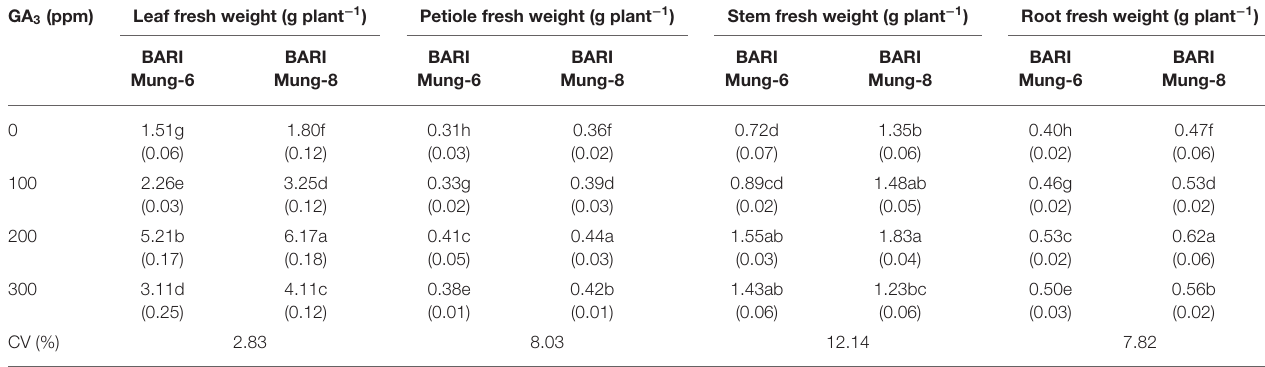
TABLE 5 | Effect of GA 3 on the fresh weight in different plant parts of V. radiata varieties. GA 3